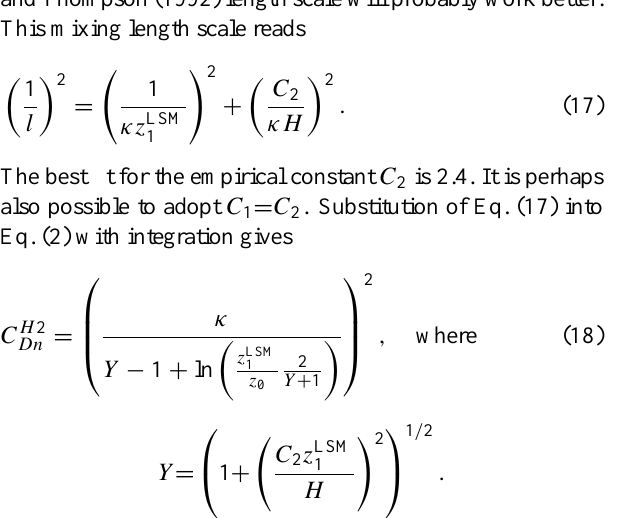
Fig. 9. The dependence of C LES Dn is given by Eq. (19). Symbols and lines are the same as in Fig.